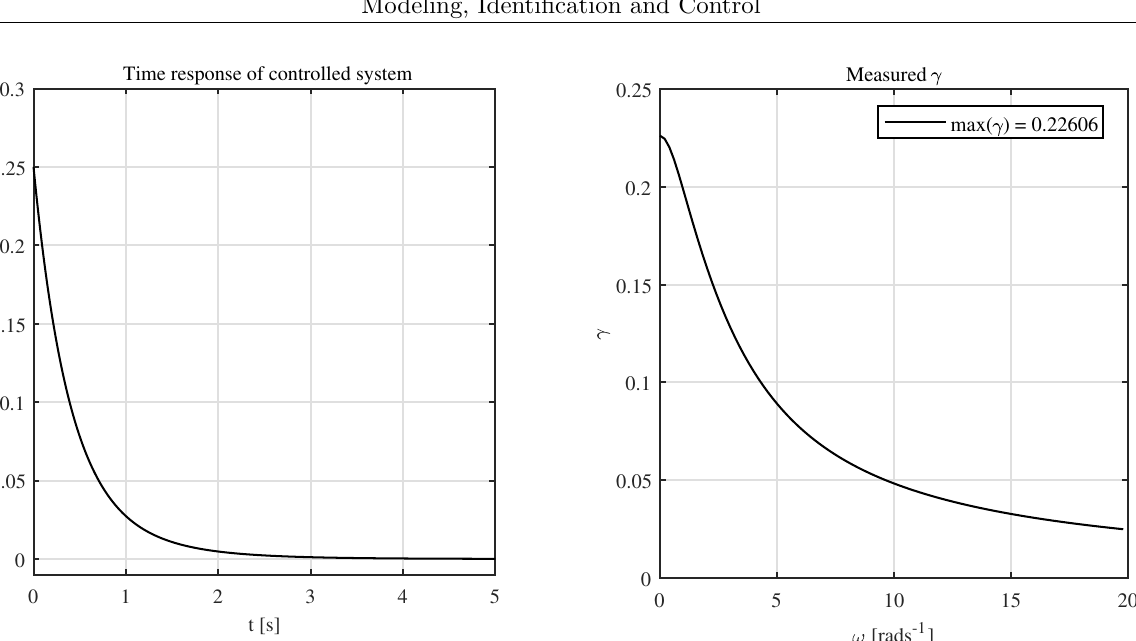
Figure 9: Measured γ according to ω . synchronization of generalized chaotic systems. The modified L 2 gain approach and the new bounded real lemma ensures less conservative BMI-based controller design due to the introduced auxiliary matrices. When the robust stability conditions hold the closed-loop system is asymptotically stable and the H ∞ norm of closed-loop transfer function with respect to the de- fined output and input is strictly less than γ ≥ 0. Nu- merical examples show the effectiveness of the proposed